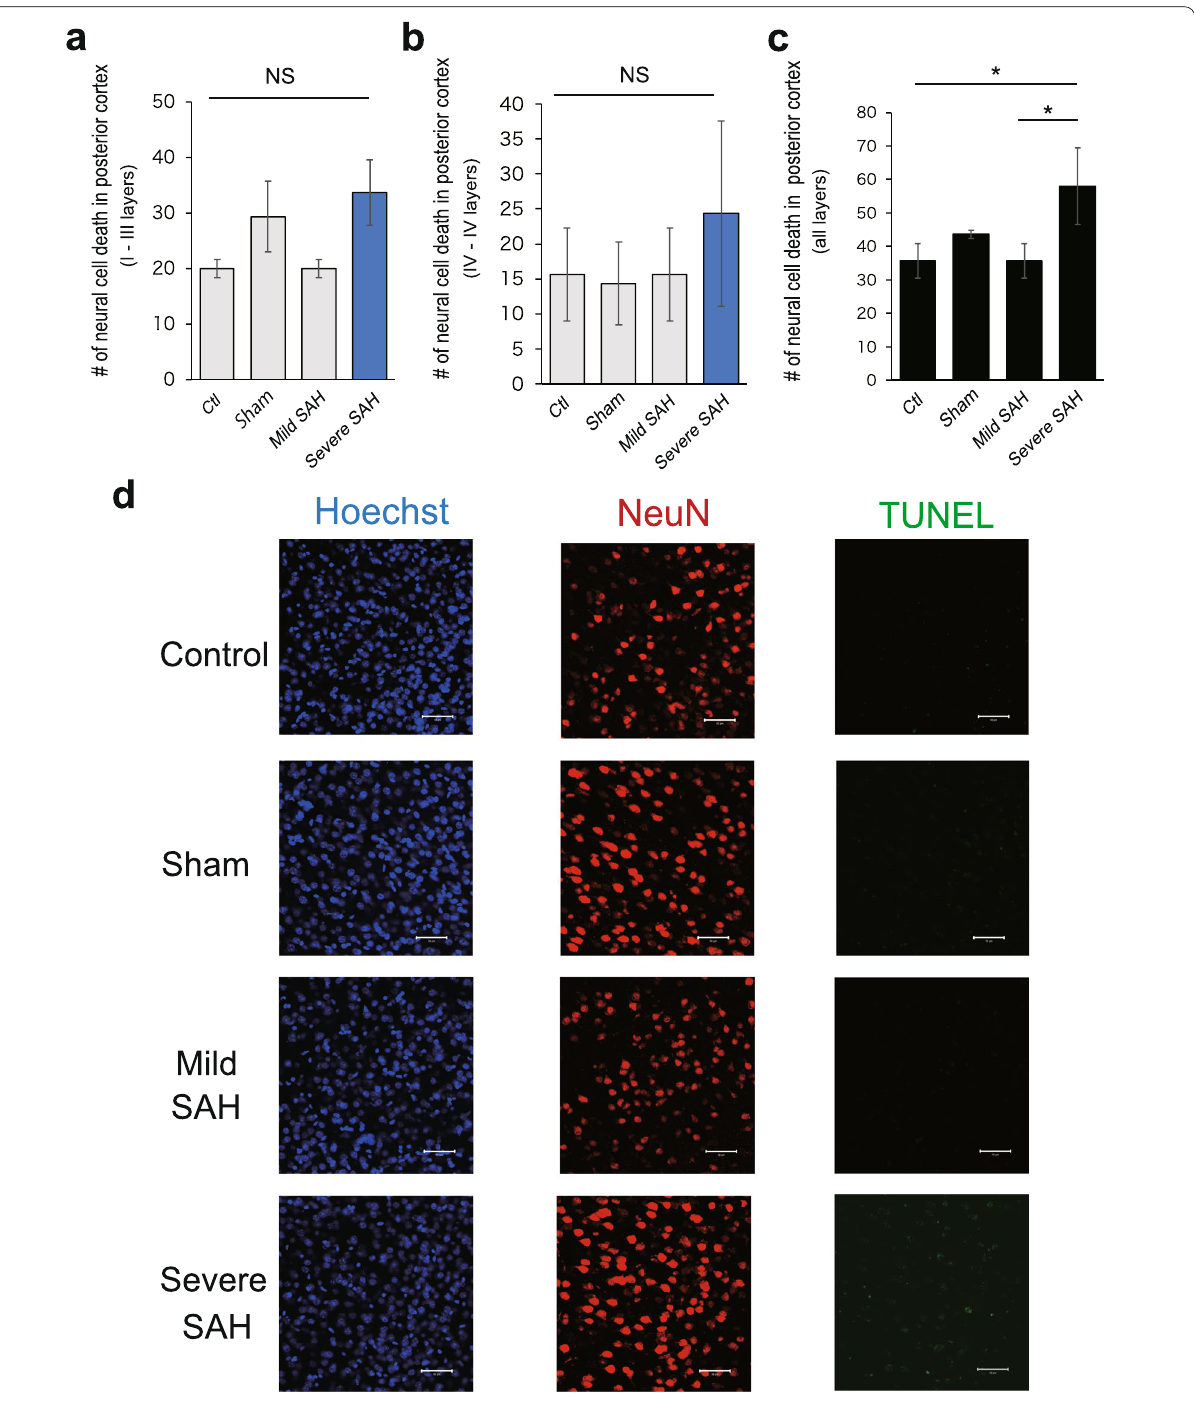
Fig. 10 Neural cell death in the posterior cerebral cortex (2.5 mm posterior to bregma). a Cells that were positive for both NeuN and TUNEL were quantified to assess neuronal cell death. The number of dead neural cells in layers I to III of the posterior region of the cerebrum was quantified ( n 3, each group). b Quantification of the number of dead neural cells in layers IV to VI of the posterior region of the cerebrum ( n = Quantification of the number of dead neural cells in all layers of the posterior region of the cerebrum ( n images of TUNEL (green) and NeuN (red) in the posterior cortex. Nuclei were counterstained with Hoechst (blue). Scale bar, 50 μm. Statistical analyses were performed with one-way ANOVA and Tukey–Kramer post hoc tests. The values in the bar graphs represent the mean NS: not